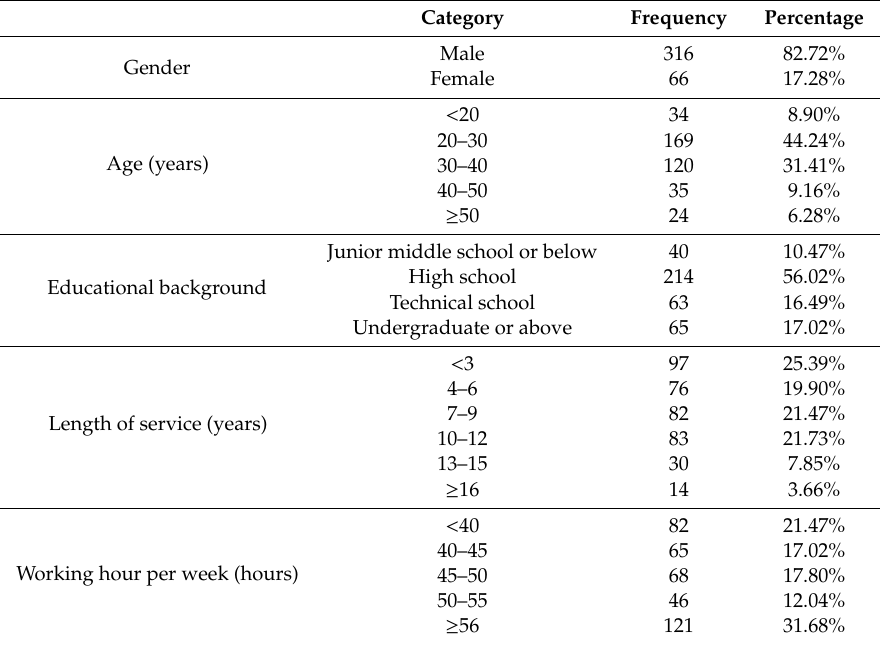
Table A1. Demographic characteristics of